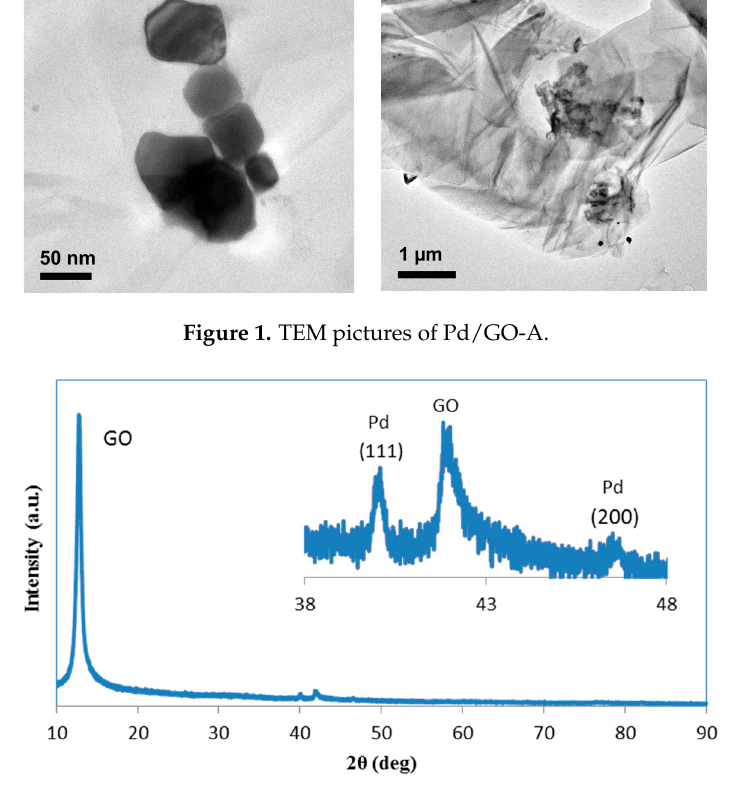
Figure 2. XRD of Figure 2. XRD of Pd/GO-A. Figure 2. XRD of Pd/GO-A.